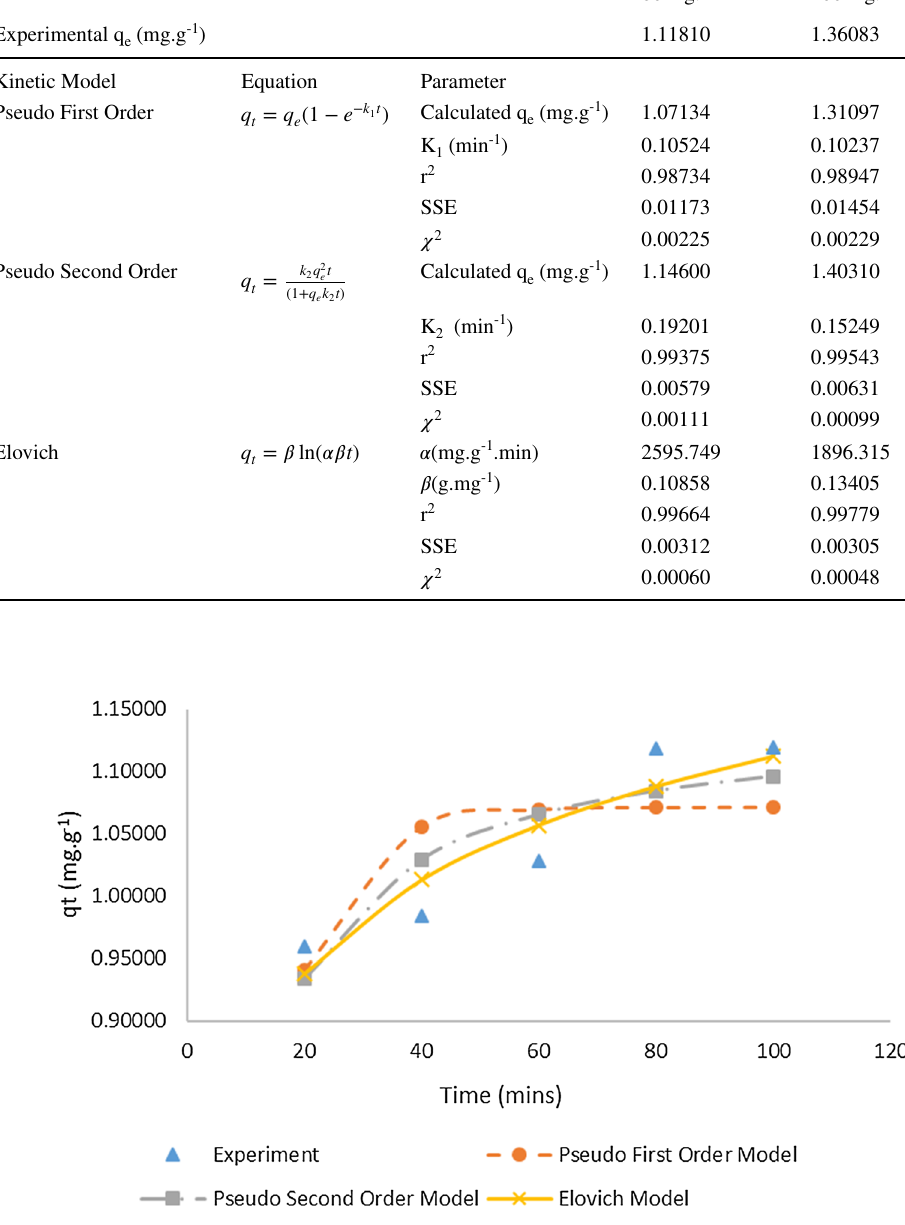
parameters and Error functions for adsorption of cyanide onto activated periwinkle shell carbon (APSC)